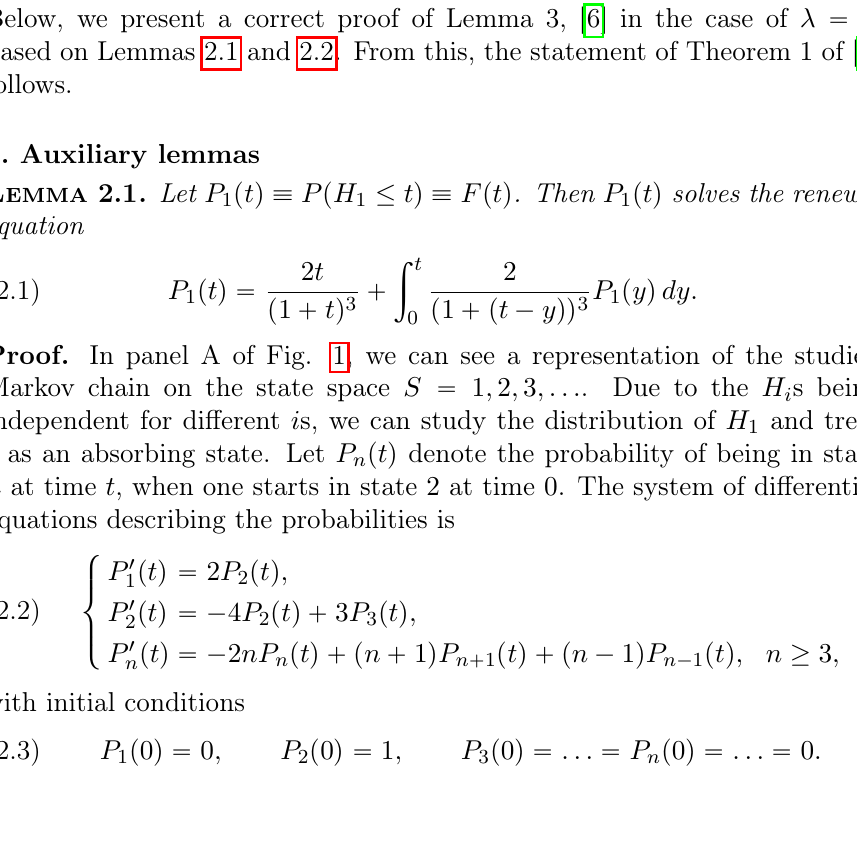
Fig. 1. A: Depiction of the Markov chain model described in [6]. B: Depiction of a classical Markov chain model for which Eq. (1.1) would be correct. The numbers inside the circles are the states (counting the number of virus type) and the numbers above and below the arrows are the birth and death rates, respectively, of the state from which they come